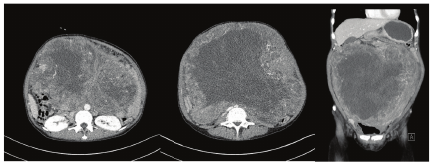
Figure 1: Abdominal computed tomography (CT) showing a huge solid mass occupying whole pelvis and abdomen.